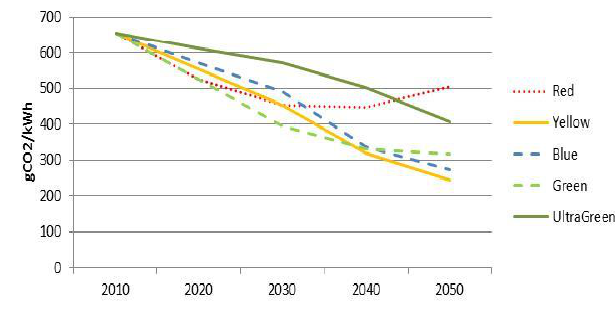
Fig. 8. Development of marginal emissions.